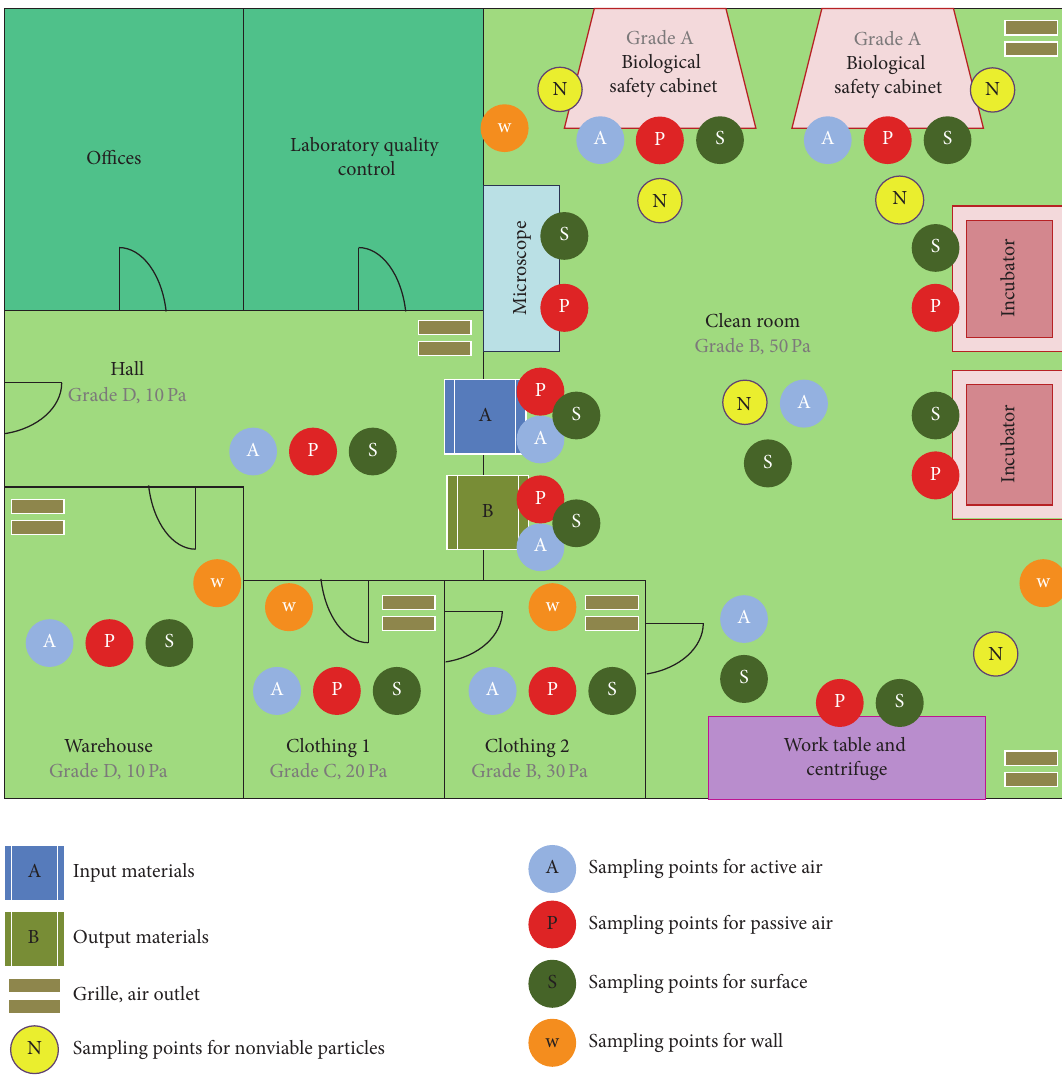
Figure 2: Diagram of cleanrooms and sampling points of environmental monitoring for stem cell units. Sampling N should be carried out whenever an activity is performed (in operation). The sampling rate for the points A, P, S, and W must be previously validated according to the requirements of the